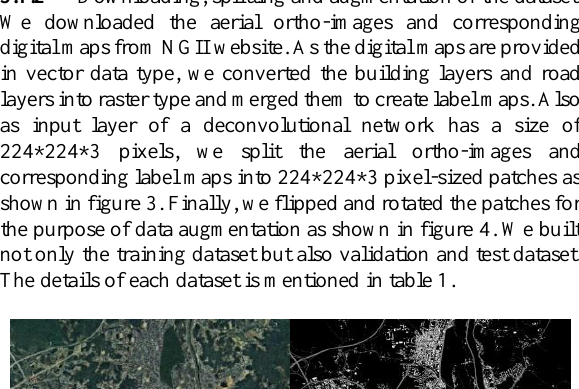
Rotate 180 deg. Rot 270 deg. Figure 4. Example of data augmentation